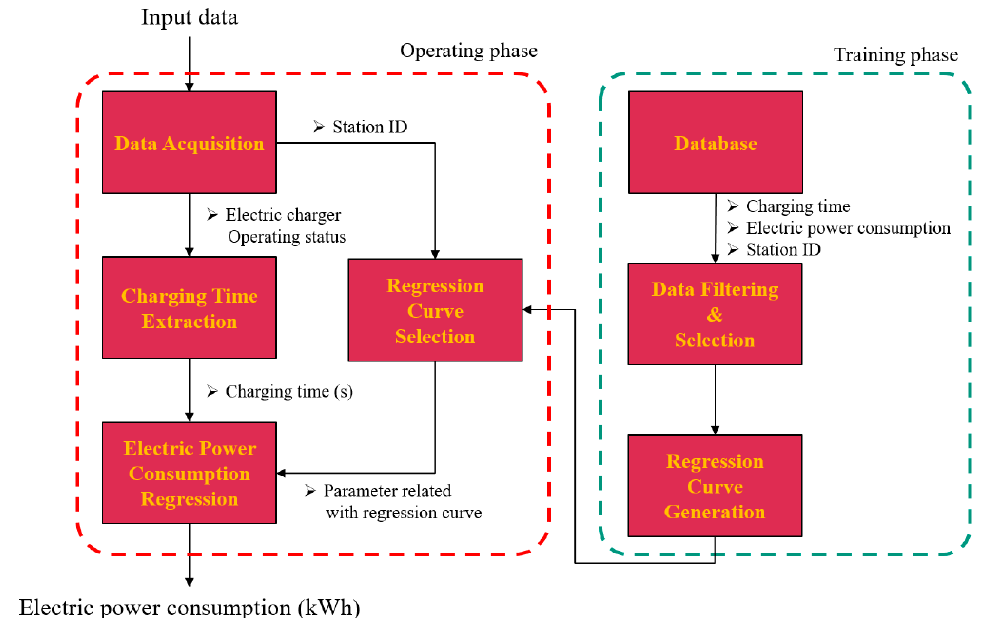
Figure 1. Block diagram of the proposed system. Station IDs are the numbers determined by the electric charger operating organizations to discriminate each station.